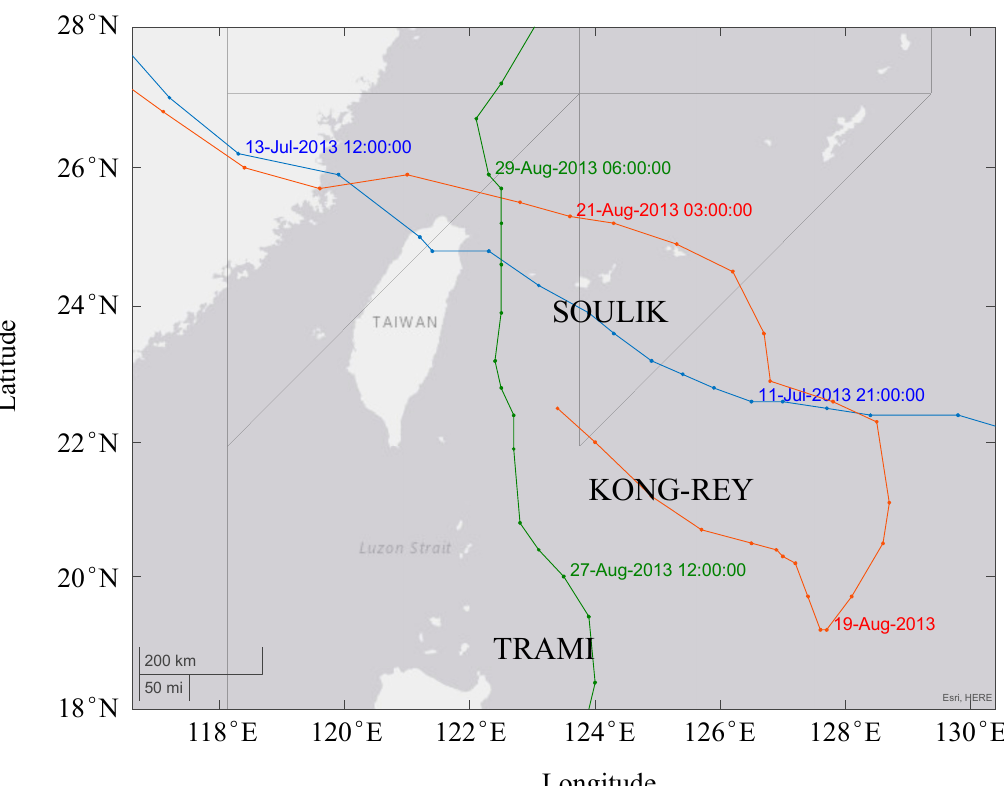
Figure 11. Three typhoons passed to the east and north of the study area during the summer period.